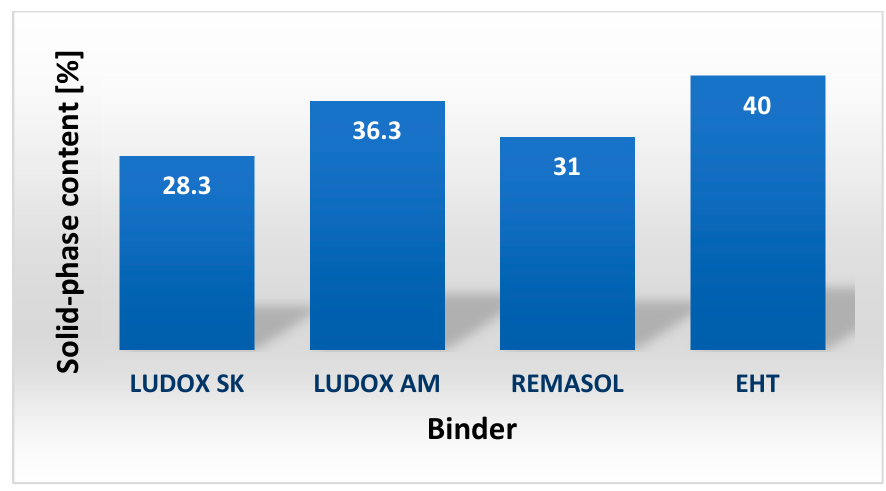
Figure 10. Solid-phase content of selected binders based on colloidal silica.